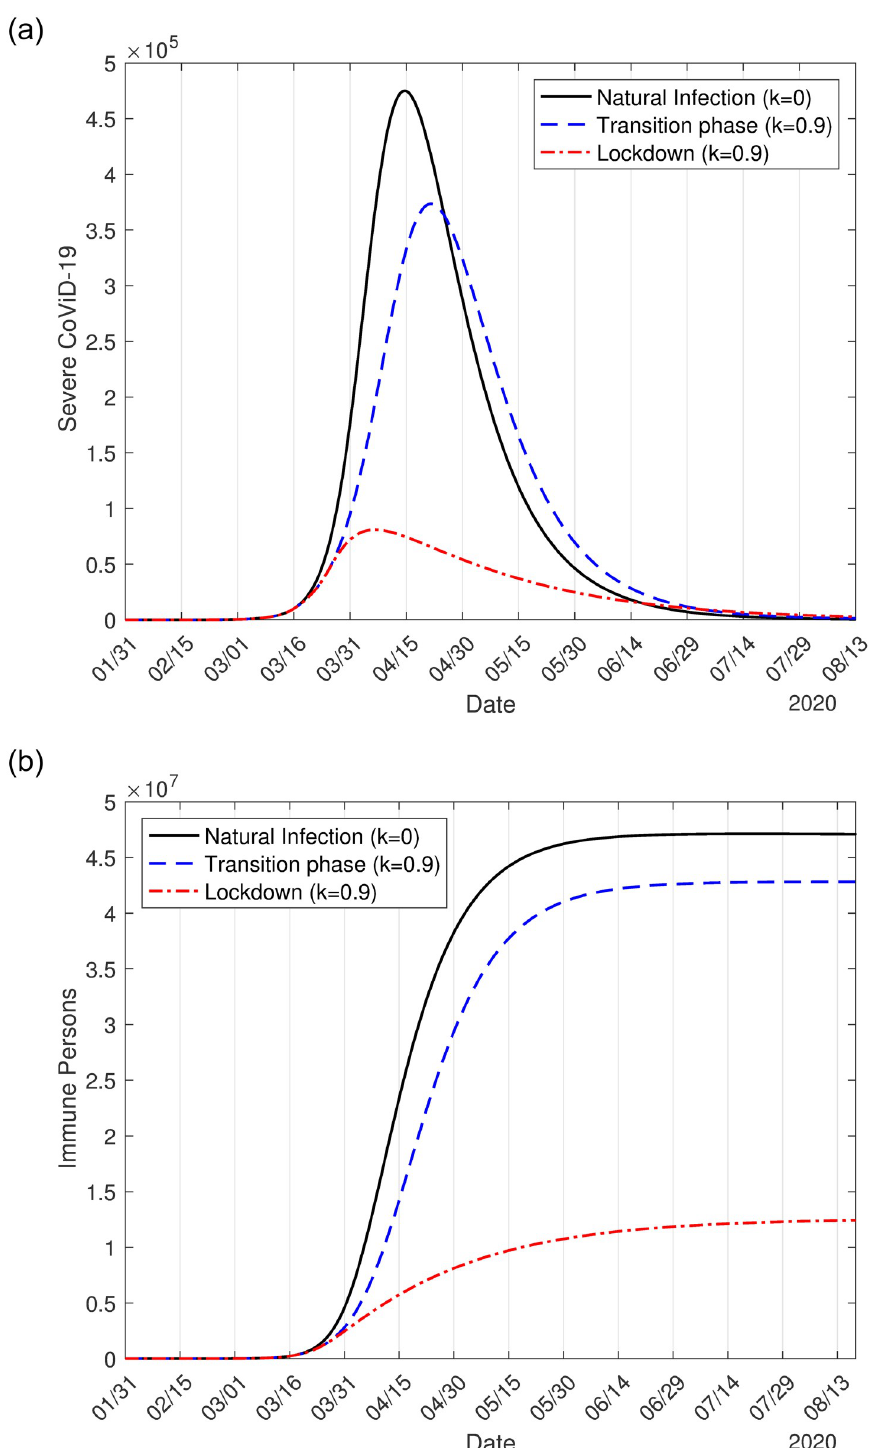
Fig 5. The curves of the natural epidemic ( k = 0), the epidemic in the transition phase ( k = 0.9), and the epidemic with lockdown ( k = 0.9) (a), and the number of immune persons I (b).